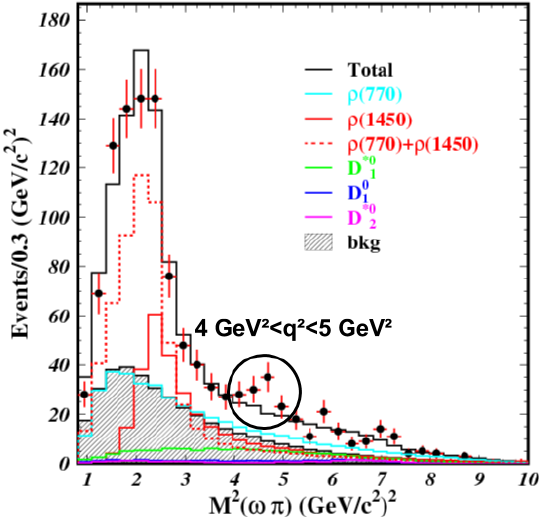
Figure 3 . (color online). The distribution of q 2 for B ! D (cid:3) !(cid:25) events measured by the Belle collaboration and taken from ref. [1]. Points with error bars show experimental data, histograms in color represent several resonant contributions and black histogram describes the signal (cid:12)t. The region 4 GeV 2 < q 2 < 5 GeV 2 is specially